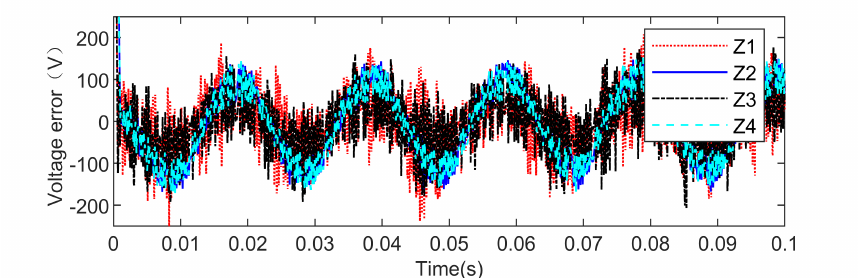
Figure 7. Output voltage RMS error under different